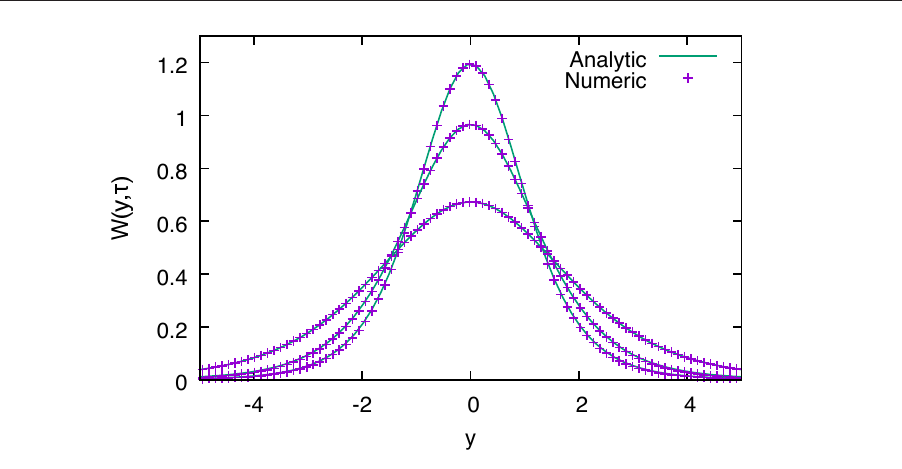
Figure 1. Comparison of the analytical (solid curves) and numerical (crosses) solutions for q = 1 . 3 at di ff erent dimensionless times τ = 0.2, 0.5, 0.8, top to bottom at y = 0. From